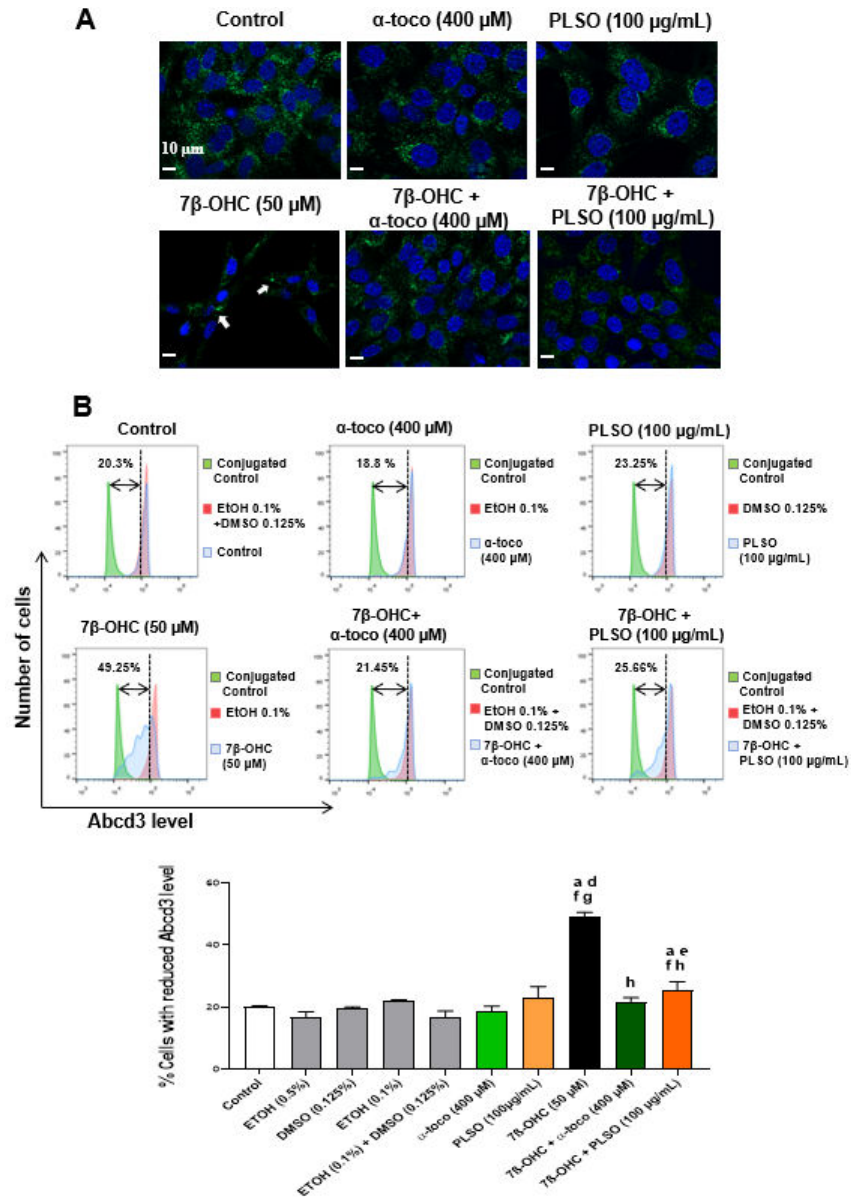
Figure 5. Effect of Pistacia lentiscus L. seed oil (PLSO) and 7 β -hydroxycholesterol on the expres- sion of the major peroxisomal membrane transporter (Abcd3) used to evaluate the peroxisomal topography and mass . C2C12 cells were incubated for 24 h with or without 7 β -OHC (50 µ M) in the presence or absence of PLSO (100 µ g/mL) or α -tocopherol (400 µ M). The protective effect of PLSO and α -tocopherol (400 µ M) against 7 β -OHC were analyzed by structured illumination microscopy (apotome) ( A ) and flow cytometry ( B ). The white arrows point towards cells with an accumulation of peroxisomes in a particular area of the cytoplasm. The data are presented as the mean ± SD of two in- dependent experiments performed in triplicate. A multiple comparative analysis between the groups, taking into account the interactions, was carried out using an ANOVA test followed by a Tukey’s test. A p -value less than 0.05 was considered statistically significant. The statistically significant differences between the groups, which are indicated by different letters, take into account the vehicle used. a: comparison versus control; b: comparison versus ETOH (0.5%); c: comparison versus DMSO (0.125%); d: comparison versus ETOH (0.1%); e: comparison versus (ETOH (0.1%) + DMSO (0.125%)); f: comparison versus α -toco (400 µ M); g: comparison versus PLSO (100 µ g/mL); h: comparison versus 7 β -OHC (50 µ M); i: comparison versus 7 β -OHC (50 µ M) + α -toco (400 µ M). In addition, no significant differences were observed between the untreated (control) and vehicle-treated